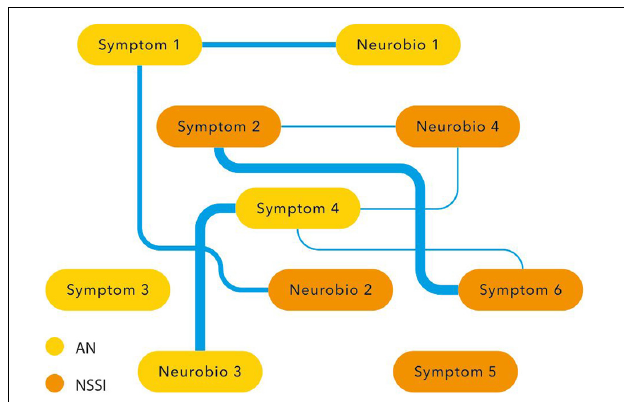
FIGURE 4 | Conceptualization of the relationship between AN and NSSI via network